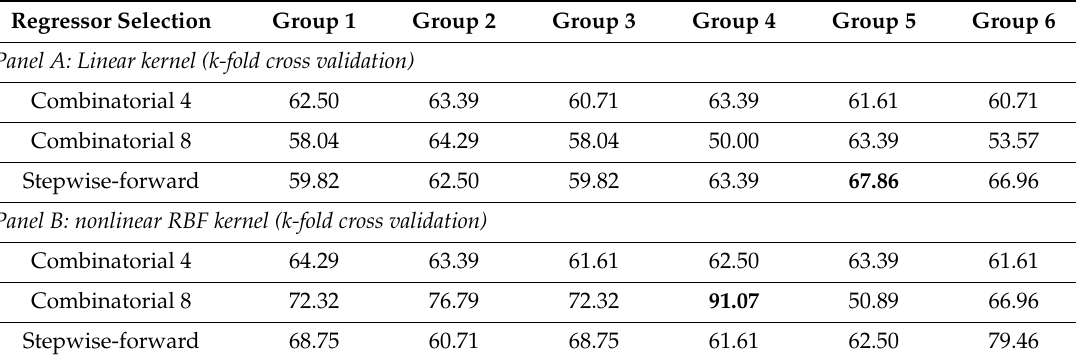
Table 7. Bank Rating forecasting accuracy by the Support Vector Machines (SVM) model